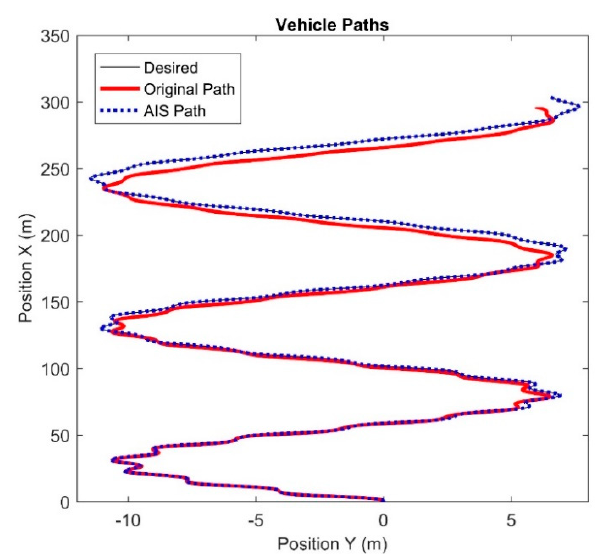
Figure 10. The desired trajectory of the vehicle (black) along with the original path the faulted vehicle (red) the path the vehicle would follow after compensation from the AIS (blue dots).